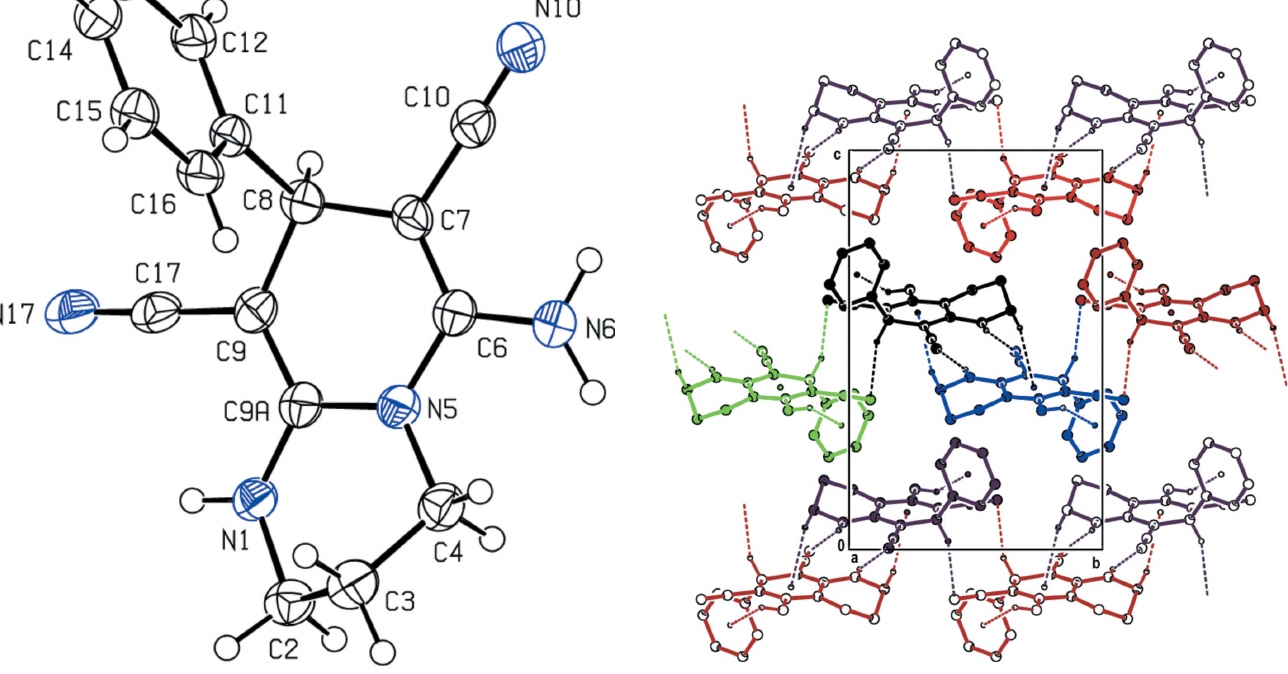
Figure 1 The molecular structure of the title compound with displacement ellipsoids drawn at the 50% probability level.